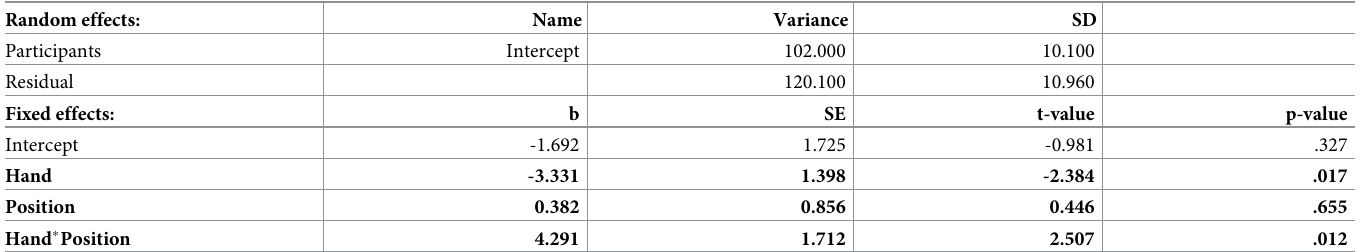
Table 2. Model 1.2. Main effect of Position on grip force in the time window 680–760 ms (Experiment 1).